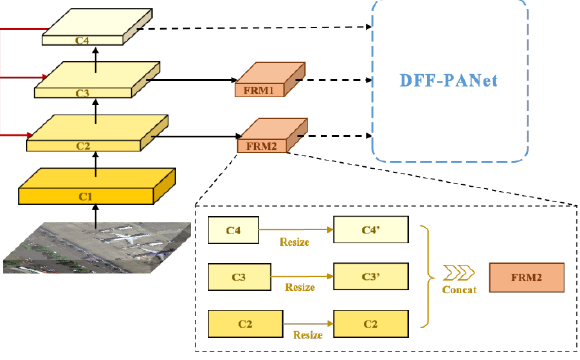
Figure 4. Feature Reuse